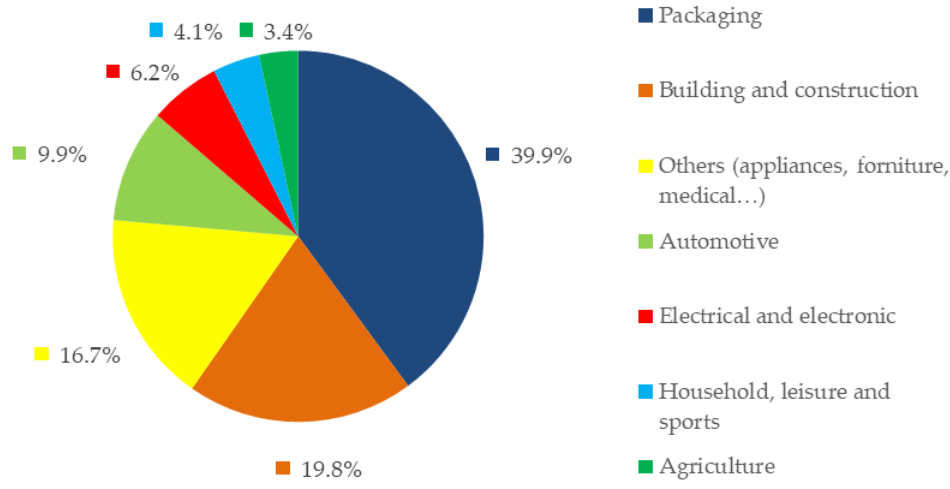
Figure 1. Distribution of the European (EU28 + NO / CH) use sectors of plastic material in 2018 [4]. Typical polymers used for packaging are PP (polypropylene), PE-LD (low density polyethylene), PE-LLD (low linear density polyethylene), HDPE (high density polyethylene), PS (polystyrene), EPS (expanded polystyrene), PVC (polyvinyl chloride), and PET (polyethylene terephthalate) [5,6]. Packaging has many applications not only for the storage and transport of products but also in guaranteeing their integrity and protection from humidity, breakage, dust, and microorganisms [7]. Massive uses of packaging are typical of the food, beverage, cosmetics, and pharmaceutical industries [8].